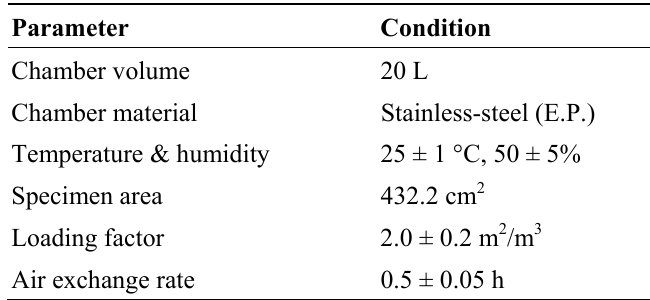
Table 2. Test conditions for the 20 L small chamber method used in this